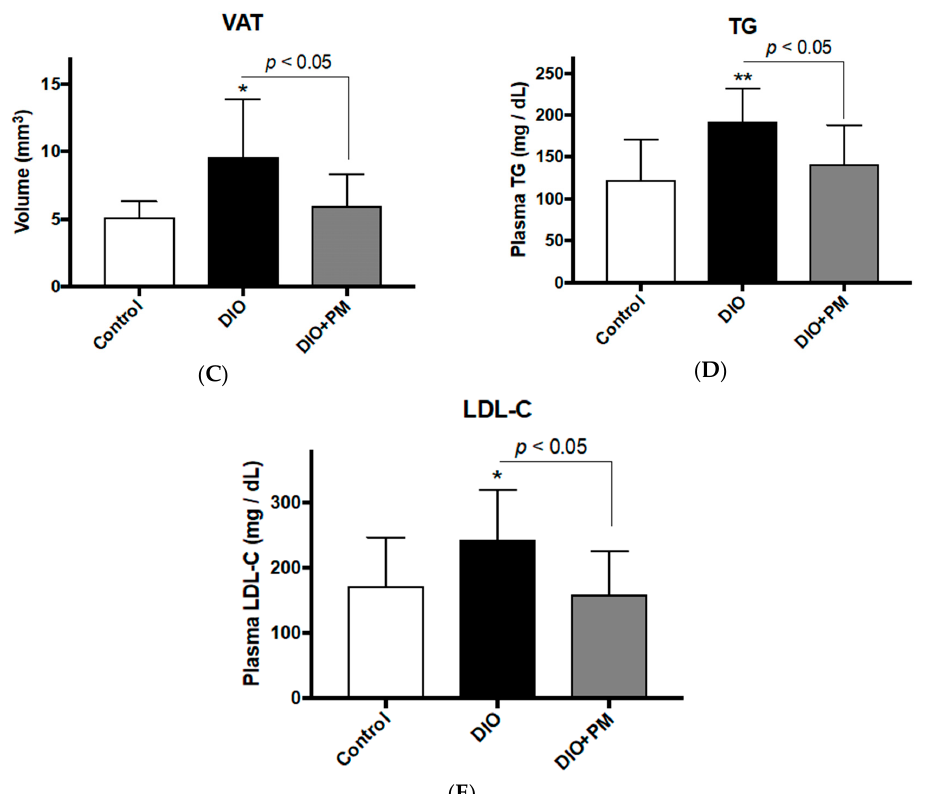
Figure 2. Pre-administration of PM in overfed DIO-zebrafish. ( A ) Schedule of PM supplementation in zebrafish Experiment 2. PM administration and overfeeding started on week –1 and week 0, respectively. ( B ) Body weight change during Experiment 2. ( C ) PM suppressed increases in visceral adipose tissues (VAT) in DIO-zebrafish in week 2. ( D , E ). PM suppressed increases in plasma triacylglycerol (TG; D ) and low-density lipoprotein cholesterol (LDL-C; E ) in DIO-zebrafish. * p < 0.05, ** p < 0.01 vs. control. # p < 0.05 between DIO and DIO + PM. n = 6–10, error bars indicate SD.